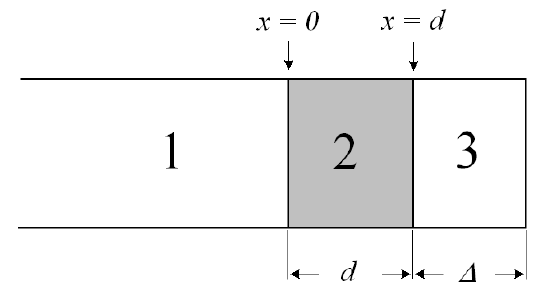
Figure 13. The scheme of inclusion of the sample.